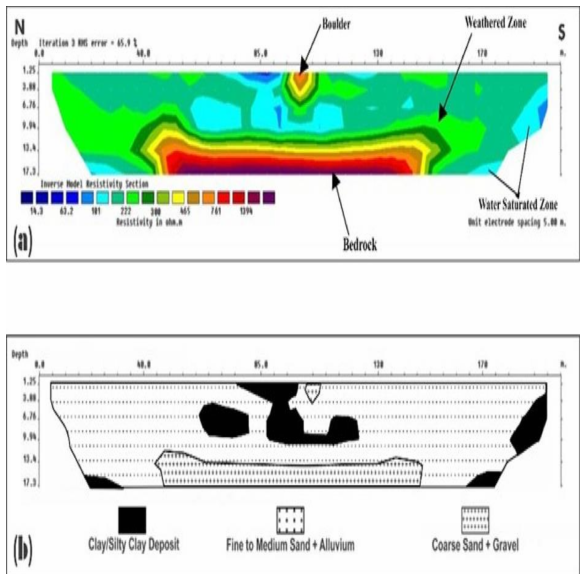
Fig. 5. (a) Profile 2 electrical resistivity tomography; (b) Geologic cross-section interpreted from the resistivity model within a sequence of horizontal sedimentary sequence (see Fig. 3). values above 649 Ω